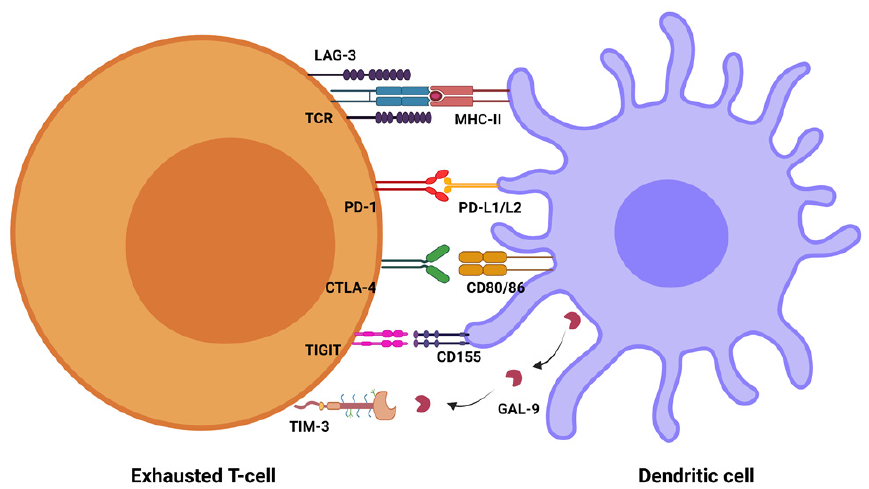
Figure 1. Immune checkpoint expression by exhausted T-cells in response to chronic viral infection. PD-1: programmed cell death protein 1, PD-L1/L2: programmed death-ligand 1/2, CTLA-4: cytotoxic T lymphocyte antigen 4, LAG-3: lymphocyte activated gene-3, GAL-9: galectin-9, TIM-3: T-cell immunoglobulin mucin-3, TIGIT: T-cell immunoglobulin and immunoreceptor tyrosine-based inhibitory motif, TCR: T-cell receptor, MHC-II: major histocompatibility complex.